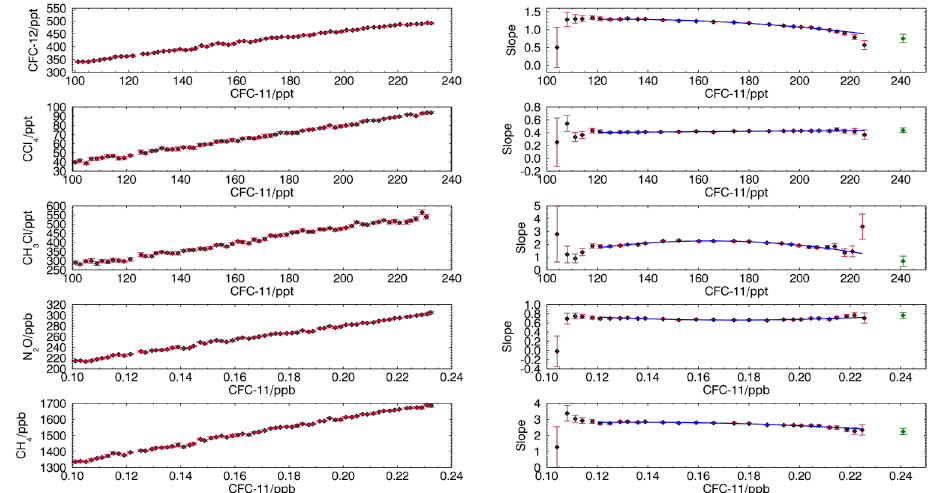
Figure B17 Correlations between the volume mixing ratios of CFC-12, CCl 4 , CH 4 , CH 3 Cl and N 2 O and CFC-11 for the data from the southern hemisphere during the stratospheric winter of 2006. Left panels: The mean correlation profile. Each point represents the mean of the VMR in a window of 2 ppt of CFC- 11. The error on these points is the standard deviation of the data within each 2 ppt window. Right panels: The local slope of data in an 80 ppt of CFC-11 window. The error on the points is the fitting error of this fit. The blue line is a second degree polynomial fit to the local slopes. The green point is the extrapolated slope at the tropopause.